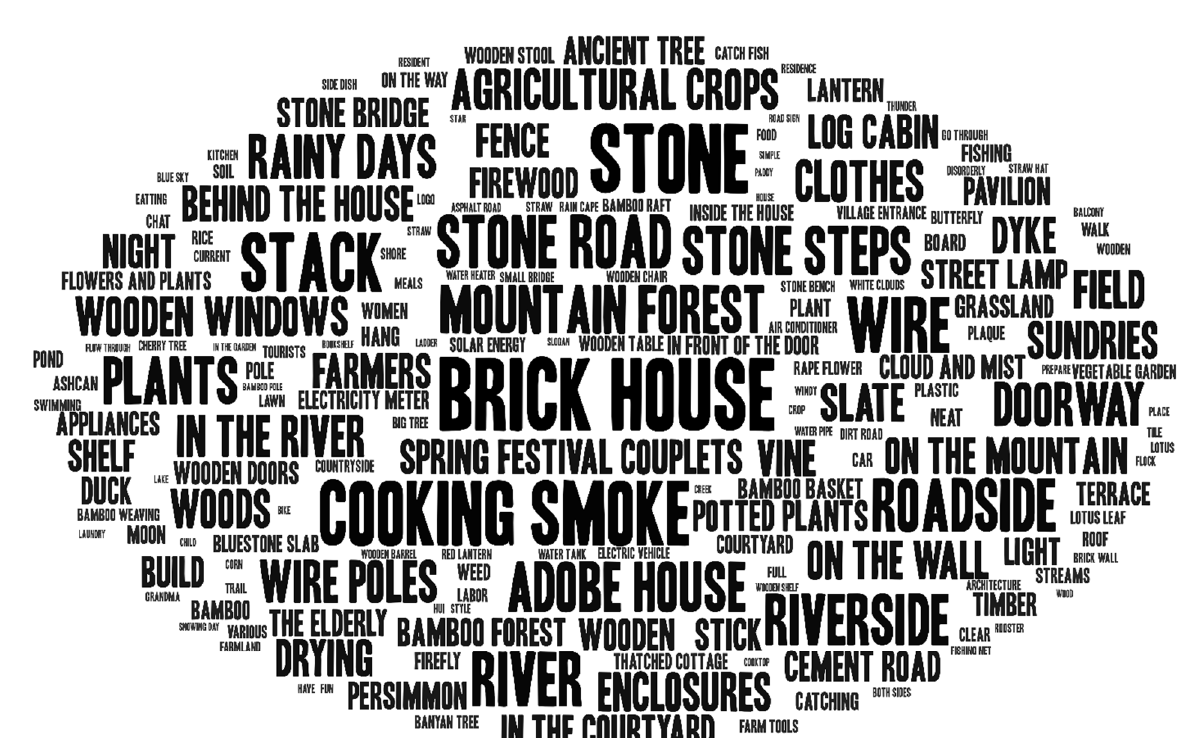
Figure 1. Basic elements of the rural landscape word cloud map. Table 2. Example analysis of the formation of basic categories of a rural landscape. Landscape Elements Basic Category moon, starry sky, stars, blue sky and white clouds, full A1 astronomical landscape moon, bright moon, night, morning... grass, banyan tree, cherry tree, persimmon tree, ancient